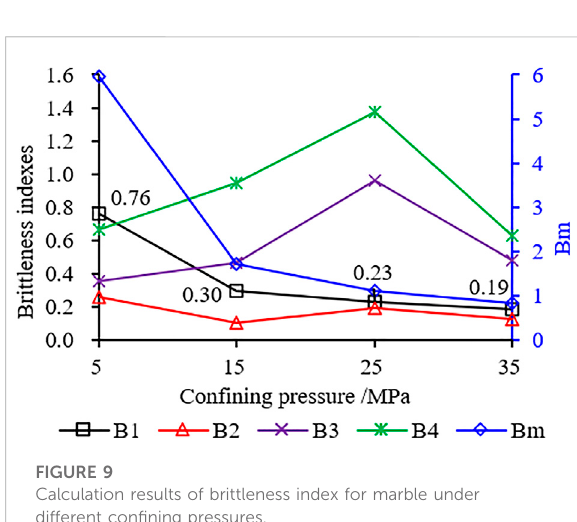
FIGURE 9 Calculation results of brittleness index for marble under different con fi ning